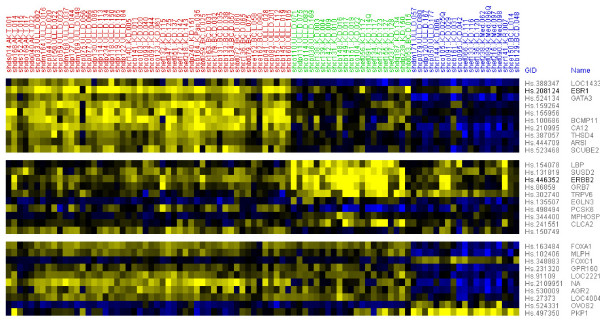
Training dataset samples dendrogram clustered on BCMP11/ABCC11 centroid genes. Thirty centroid genes present in all datasets that best distinguish the three BCMP11/ABCC11 groups. The first group of genes are the top ten genes that distinguish Group 1 from Groups 2 and 3; the second group of genes are the top ten genes that distinguish Group 2 from Groups 1 and 3; and the last group of genes are the top ten genes that distinguish Group 3 from Groups 1 and 2. The samples in BCMP11/ABCC11 Group 1 (ERBB2-/ESR1+) are in red; the samples in BCMP11/ABCC11 Group 2 (ERBB2+) are in green; and the samples in the BCMP11/ABCC11 Group 3 (ESR1-/ERBB2-) are in blue.